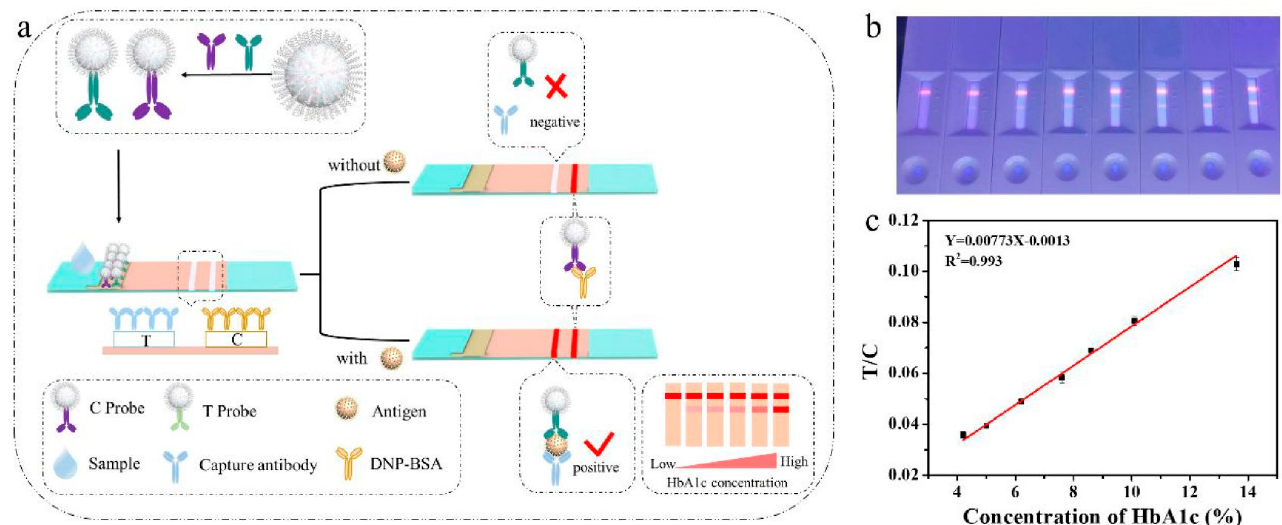
Figure 17. Optical immunosensor for glycosylated hemoglobin in blood samples. ( a ) Fluorescent BSA-wrapped CdSe-ZnSQDs conjugated to antibodies targeting the glycosylated hemoglobin are adsorbed onto a nitrocellulose membrane. ( b , c ) When the analyte is loaded, it binds to the fluorescent QDs that migrate towards a revelation zone where anti-human hemoglobin antibodies are present. A double fluorescent signal is detected; otherwise, in the absence of the analyte only the control fluorescent band is visible. Image adapted from [116] with permission of American Chemical Society, 2022.